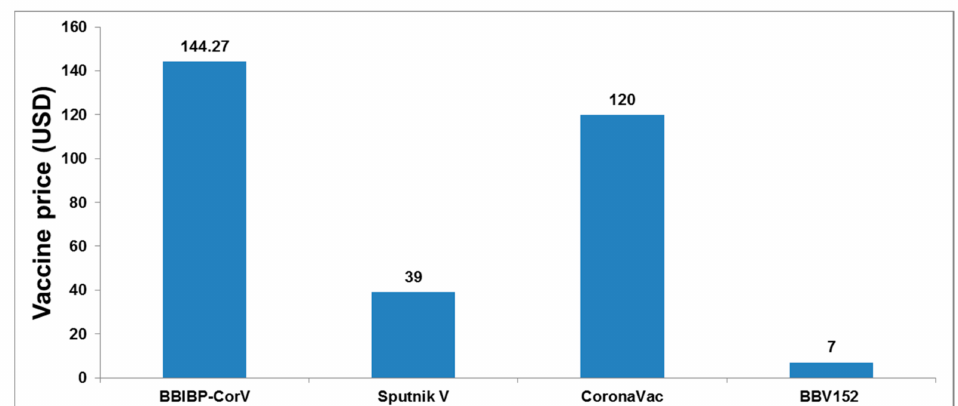
Figure 13. The cost of some Asian-origin COVID-19 vaccines. Presently, the Covaxin vaccine is distributed free from the government hospital for low-income peoples and USD 7 from private hospitals